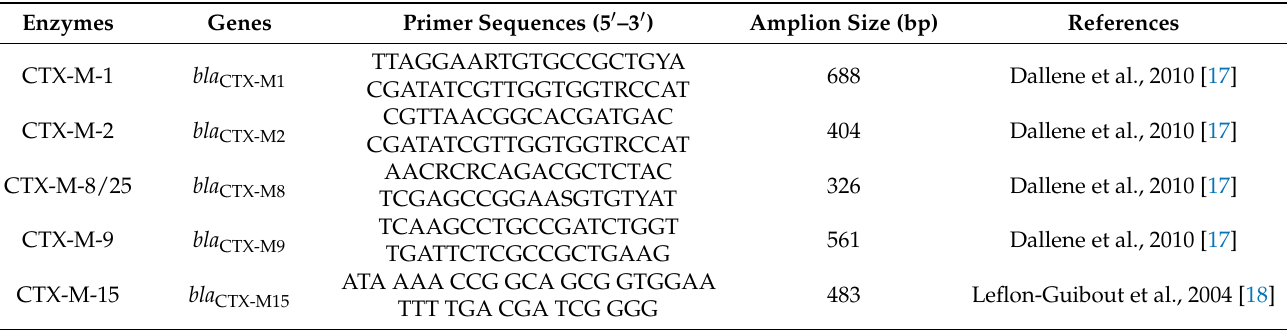
Table 1. Genes encoding CTX-M ESBL